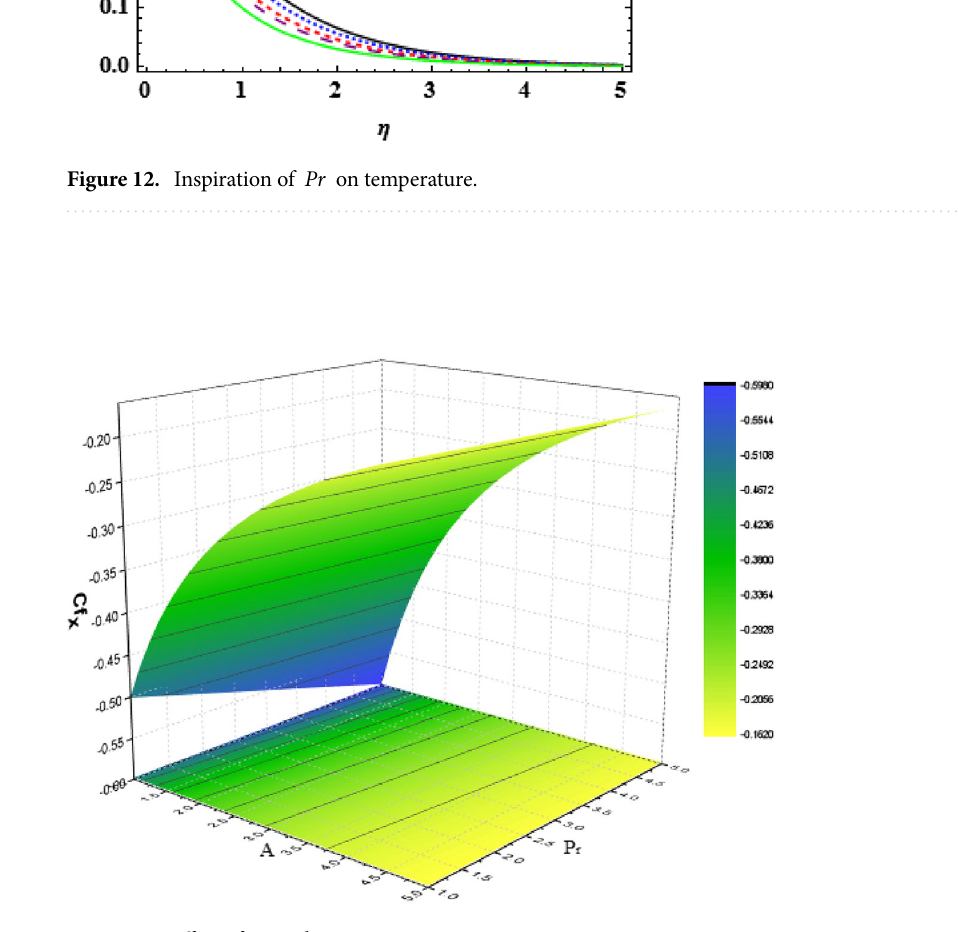
Figure13. Effect of A and p r on